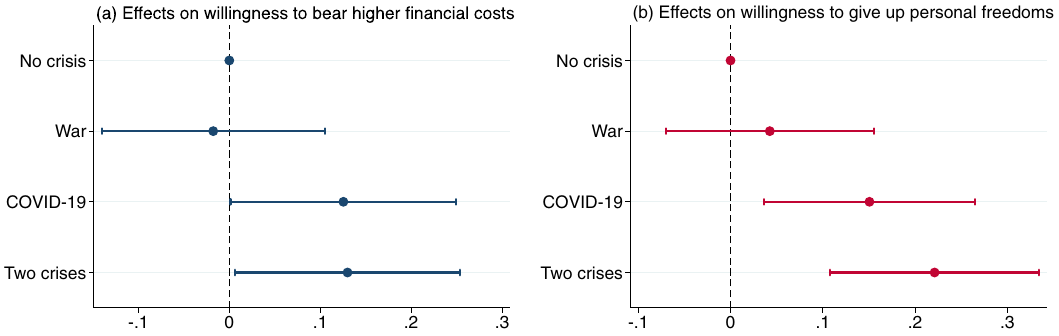
Fig. 1 Average treatment effects on willingness to support climate change mitigation measures. a Effects on willingness to bear higher fi nancial costs (type 1). b Effects on willingness to give up personal freedoms (type 2). The estimates are based on linear models controlling for demographics (age, education, gender), car usage, political orientation, climate change perceptions, and trust in science and government. Dots without bars indicate the reference category. Bars indicate 95% con fi dence intervals. We applied listwise deletion to deal with missing data. The results rely on a n = 4542 and b n = 4541 respondents. Full results are shown in Supplementary Table 1.